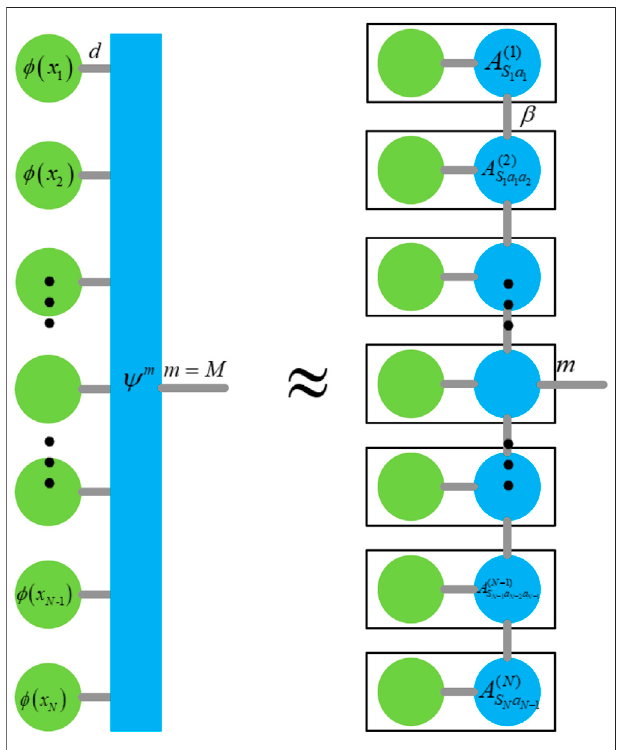
FIGURE 3 | Linear model of the decision module in audio